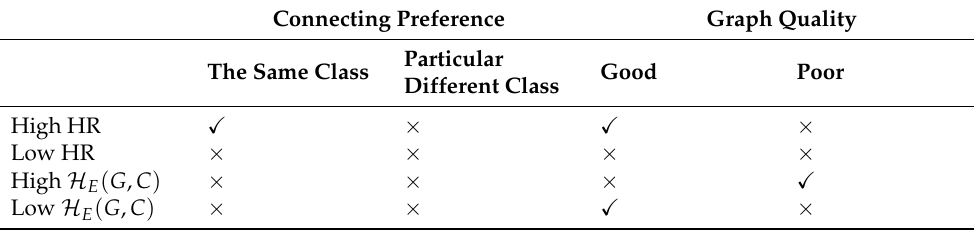
Table 3. Comparison between homophily ratio (HR) and edge information entropy( H E ( G , C ) ). Connecting Preference Graph Quality Particular The Same Class Different